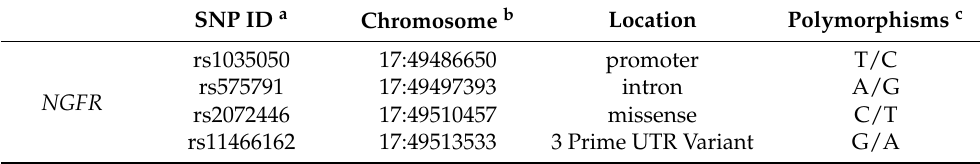
Table 1. NGFR SNPs analyzed in this